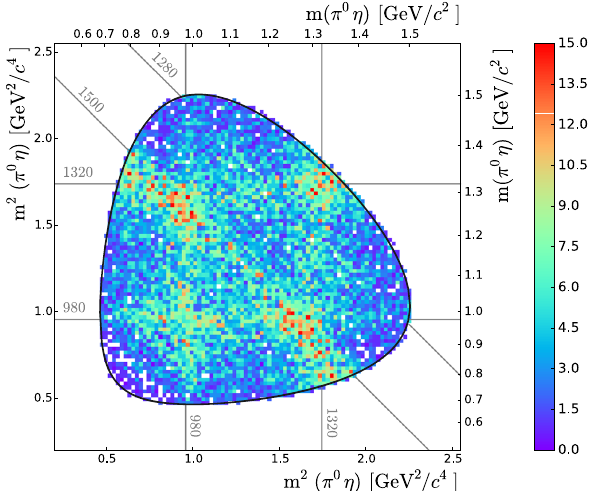
Fig. 4 Dalitzplotforthe π 0 ηη dataafterapplicationofthebackground suppression, not corrected for acceptance. Some resonance masses of interest are marked with thin black lines and gray labels (two entries per event)